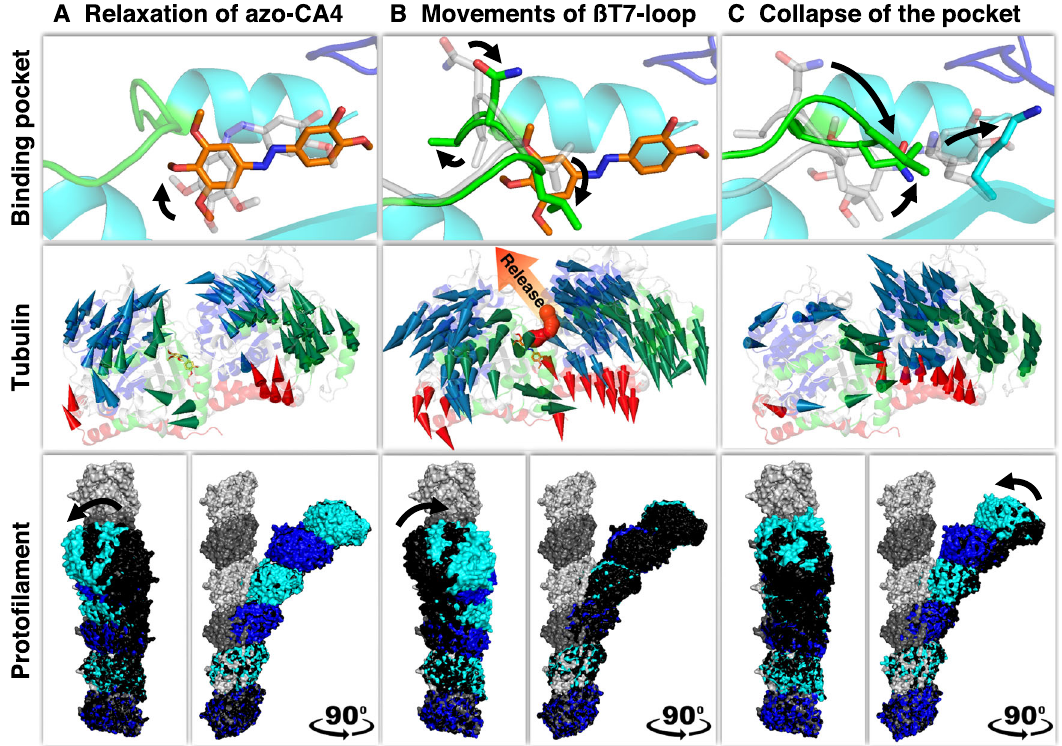
Fig. 4 | Correlation between colchicine-site dynamics and global tubulin backbonerearrangements.A Relaxationofazo-CA4:darkto100ns. B Movements of β T7 loop: 100ns to 1ms. C Collapse of the colchicine site: 1ms to 100ms. The three rows depict conformational changes at different spatial levels: Binding pocket in the upper row, tubulin backbone in the middle row, and longitudinally aligned tubulin dimers in the lower row. Starting structures are shown in gray. Backbonemovementswithintubulin(middlerow)arerepresentedbymodevectors between consecutive time delays. Every second C α -backbone atom in the main secondary structural elements with a displacement of at least 0.5Å is shown. The N-terminal nucleotide-binding domains, the C-terminal domains, and the inter- mediate domains for both α and β tubulin are shown in blue, red, and green,